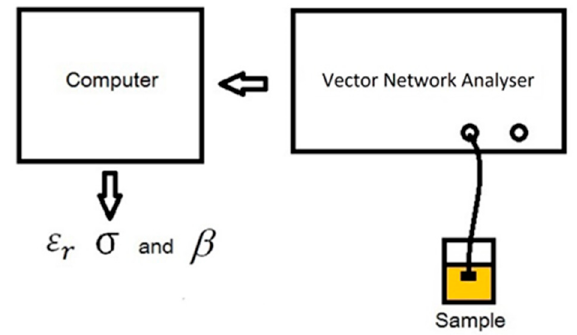
Figure 5. A sketch of the experimental setup.